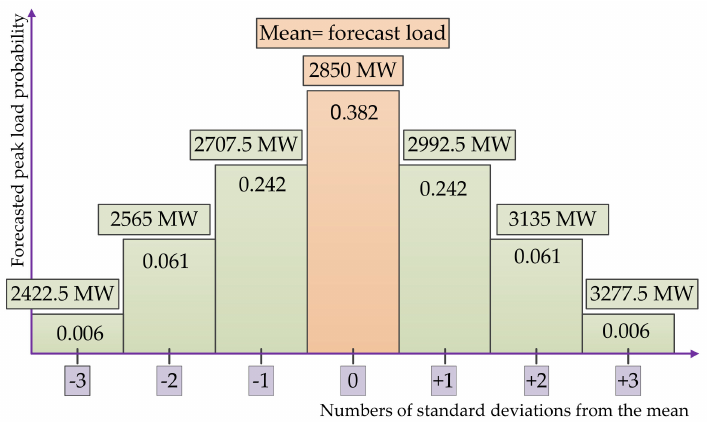
Figure 8. Seven-step approximation of the normal distribution.